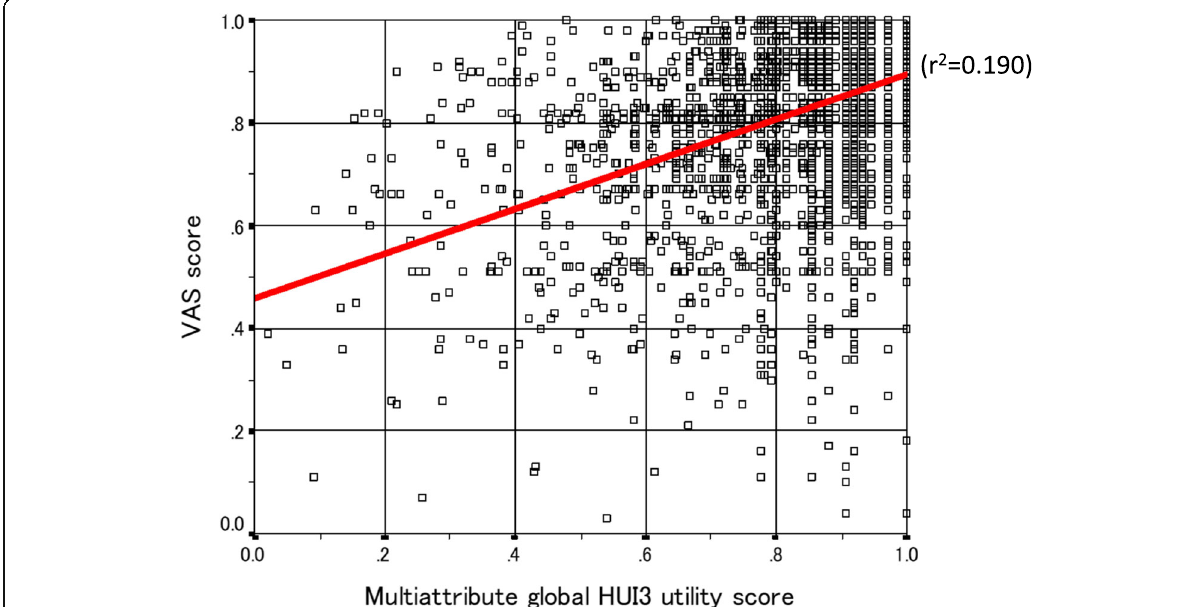
Fig. 2 Relationship between multiattribute global HUI3 utility score and VAS